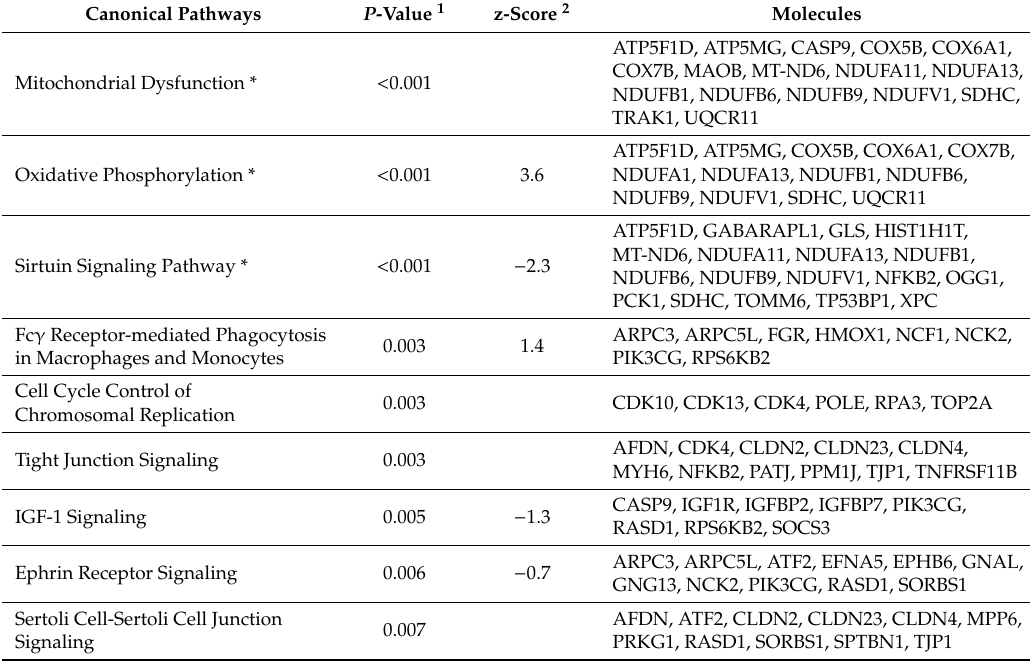
Table 1. Significantly enriched canonical pathways deduced from genes found to be di ff erentially expressed between low and high PU